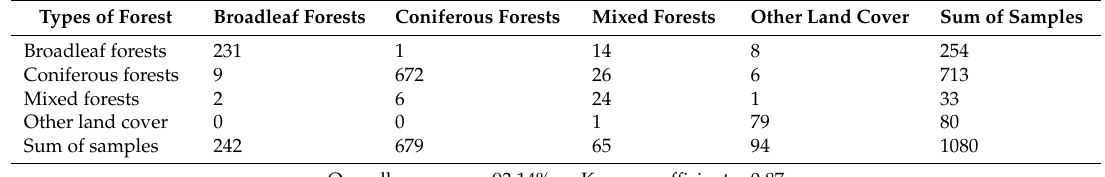
Table 5. Accuracy evaluation result of forest information extraction based on the confusion matrix. Types of